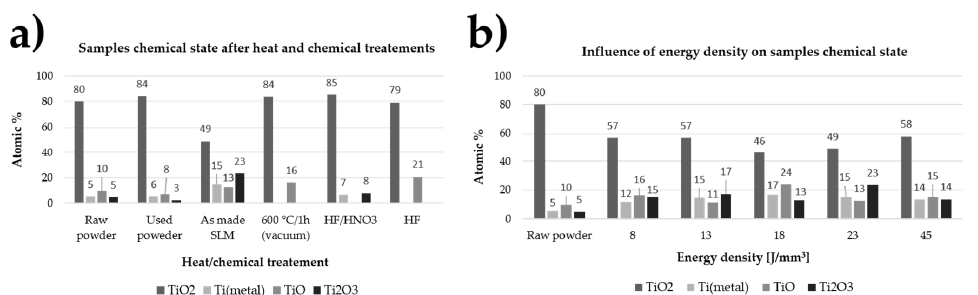
Figure 3. Influence of energy density delivered to the fabricated material ( a ) and heat and chemical treatments ( b ) on samples chemical state.